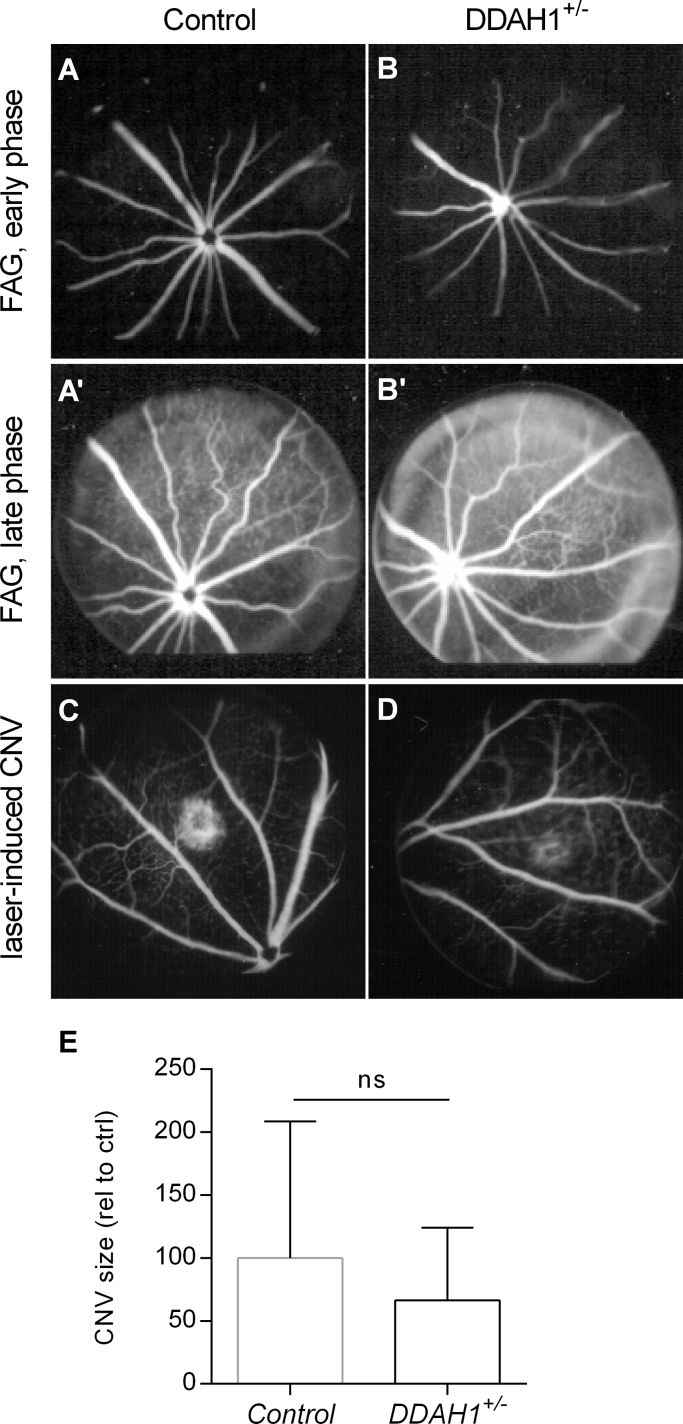
Heterozygous loss of DDAH1 does not affect vascular morphology, permeability or pathological angiogenesis in the laser-induced CNV model. A, B). Early (90 s) and late phase (7 min) fluorescein angiography in adult wildtype (left column) and DDAH1+/− knockout mice (right column, n = 5 animals per group) demonstrating no gross vascular anomalies or permeability defects. C, D) Early fluorescein angiography of laser-induced choroidal neovascularization in wildtype and DDAH1+/− knockout mice. D) Mean CNV lesion size at 7 days following laser injury (n = 4–6 animals per group). Bars represent mean (±SEM).